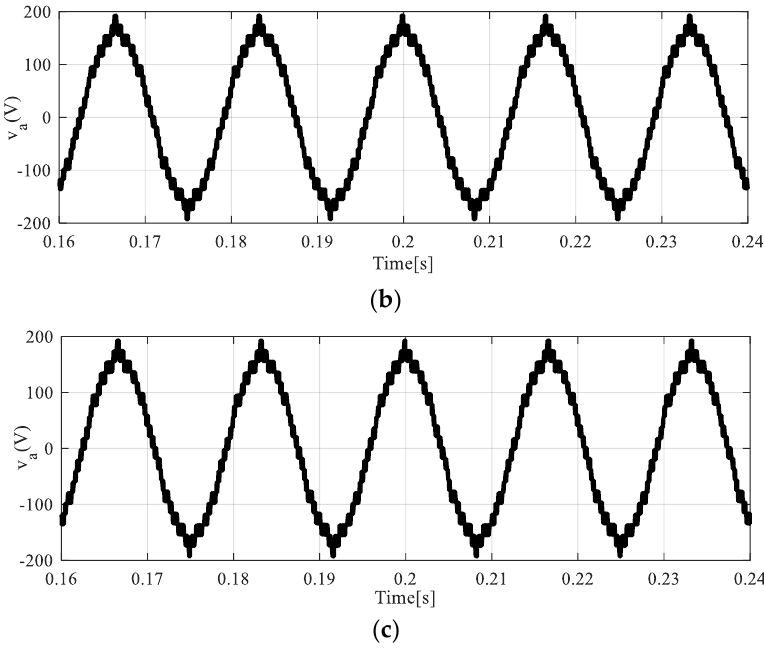
Figure 13. The output voltages of phase “a” for the ( a ) first controller, ( b ) second controller, and ( c ) third controller.